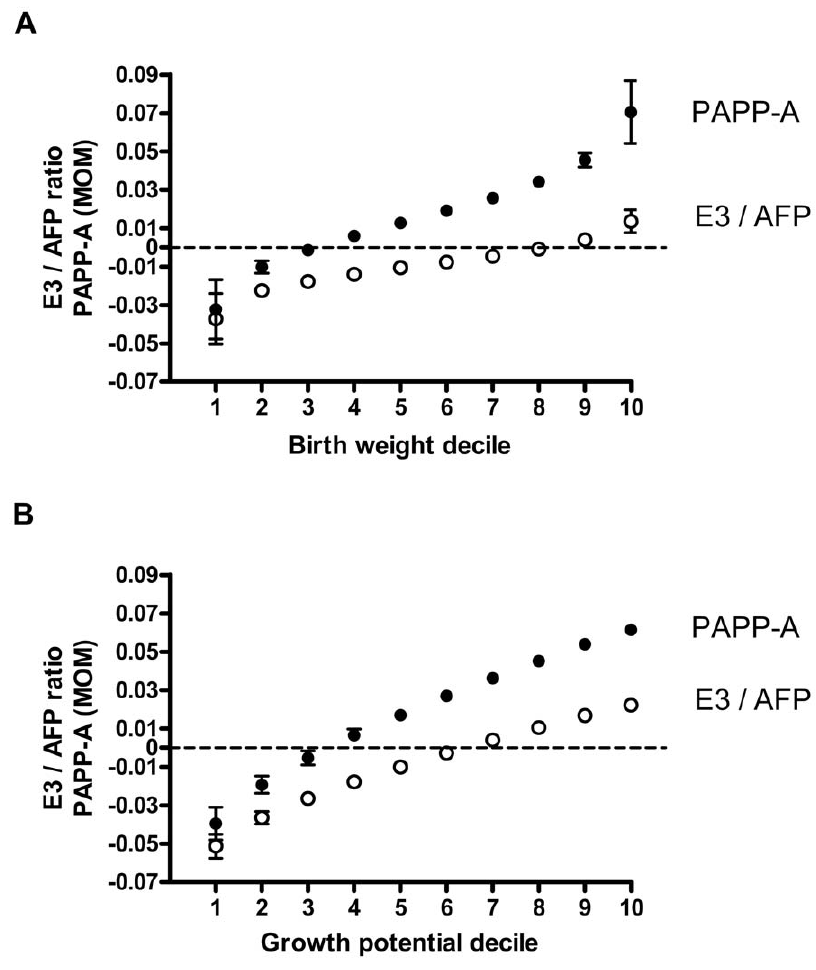
Figure 2. Association between size at birth and maternal serum estriol to alpha-fetoprotein ratio (E3/AFP) and pregnancy- associated plasma protein-A (PAPP-A) concentrations. Maternal serum concentrations of PAPP-A and ratio of E3/AFP (mean + /- SD of log 10 multiples of the median, MOM or of log 10 of ratio of MOMs, respectively) plotted against deciles of birth weight (A) or growth potential (B) at birth predicted from fractional polynomial regression analysis. Regression equations: log E3/AFP = 2 .0046098 + .0889807(gp 0 . 5 2 .6792581776); log PAPP- A = .0245553 + .1220838(gp 0 . 5 –.6792581776); P , 0.0001 for both. (gp = growth potential) log E3/AFP = 2 .0090871 + .0000268(bw-3365.677323); log PAPP-A = .0160142 + .0084278((bw/1000) 2 -11.32778384); P , 0.0001 for both. (bw = birth weight) Adjustment for maternal age, height,